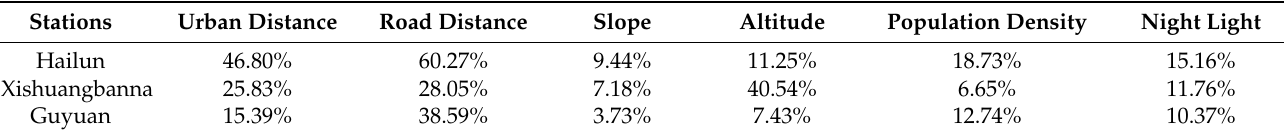
Table 6. Percentage deviation of indicator parameters in the third-layer